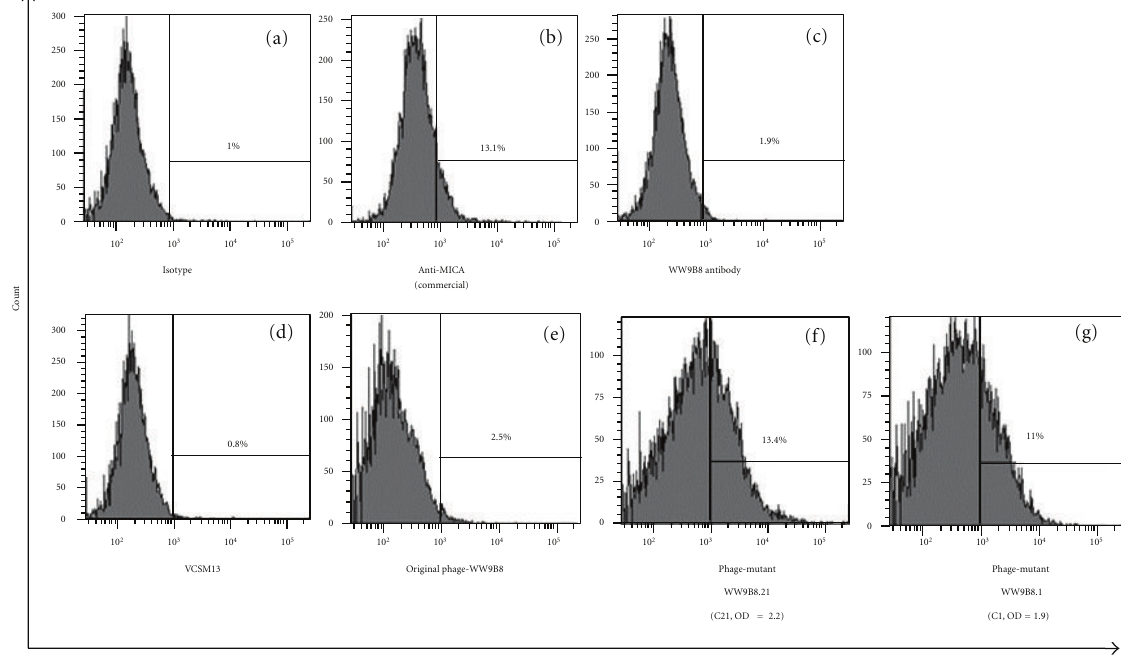
Figure 5: Characterization of anti-MICA displayed phages against MICA-positive cells by flow cytometry. 293T cells (2 × 10 5 ) were incubated with (a) mouse IgG1 isotype control PE (b) anti-human MICA antibody PE, (c) anti-MICA WW9B8 and followed by goat F(ab (cid:2) ) 2 anti-mouse IgG-PE. (d, e, f, g) 293T cells (2 × 10 5 ) were incubated with VCSM13 as negative control, original phages displaying Fab anti-MICA antibody (WW9B8), phages displaying mutant Fab WW9B8.21, phages displaying mutant Fab WW9B8.1 and followed by monoclonal antibody to M13 filamentous phage-FITC. The activities of phages displaying mutant WW9B8 are higher than the original phages carrying anti-MICA,